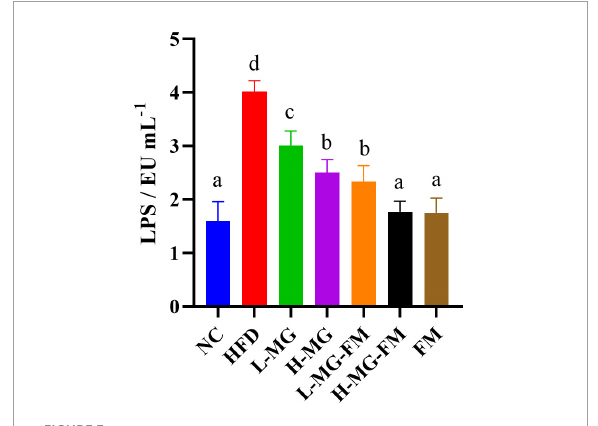
FIGURE3 Lipopolysaccharide (LPS) content in serum of mice. Different letters indicate significant differences in mice ( p < 0.05, n = 6).